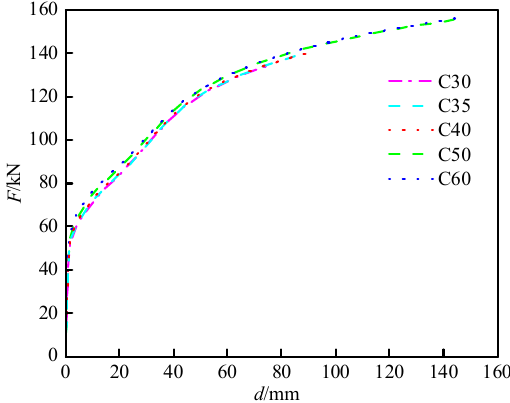
Figure 20. Load-deflection curve of specimens under different post-cast concrete strengths. Table 7. Effect of concrete strength of post-cast layer on the characteristic load. Concrete Strength of the Post-Cast Layer